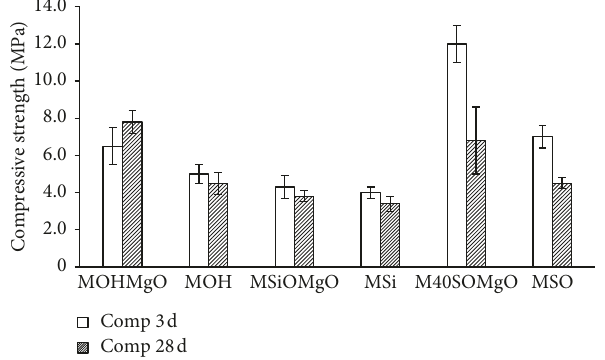
Figure 6: Effects of magnesia on strength development of lime- stone/metakaolin/calcium hydroxide